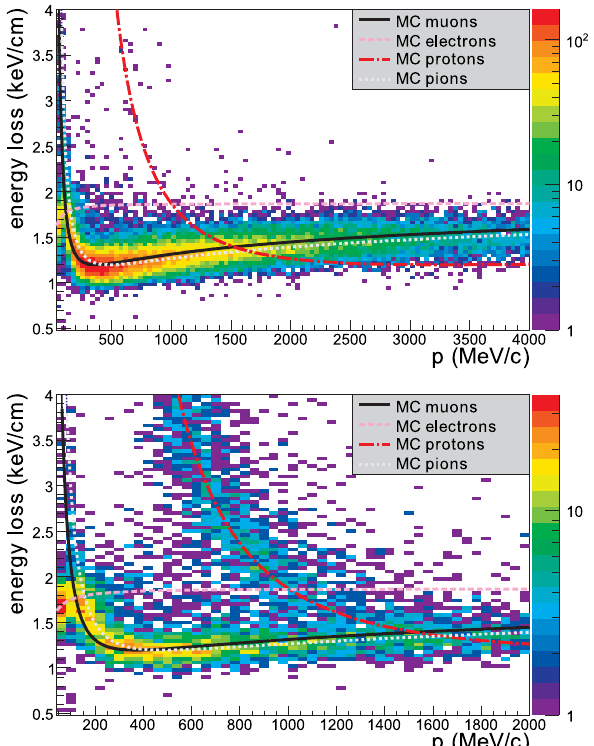
Fig. 51 Distribution of the energy loss as a function of the momentum for negatively (top) and positively (bottom) charged particles produced in neutrino interactions, compared to the expected curves for muons, electrons, protons and pions [55]